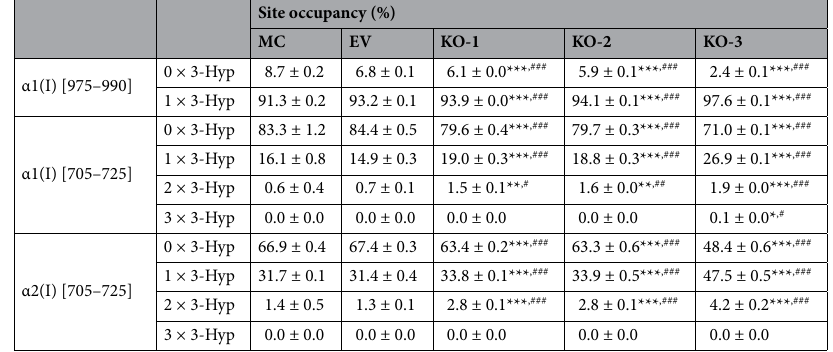
Table 6. Summary of site-specific modification analysis by mass spectrometry of prolyl 3-hydroxylation in type I collagen from controls (MC and EV) and KO clones. Prolyl 3-hydroxylation (%) represents the relative levels of prolyl 3-hydroxylation at α1 Pro-986 (0–1 × 3-Hyp), α1 Pro-707, 716, 719 (0–3 × 3-Hyp) and α2 Pro- 707, 716, 719 (0–3 × 3-Hyp) (total of 0–3 × 3-Hyp = 100%). Values represent mean ± S.D. (n = 3) of triplicate for each group. Statistical differences were determined by Kruskal–Wallis one-way analysis of variance and means comparison with the controls by Dunnett’s method. Hyp hydroxyproline, MC MC3T3-E1, EV empty vector, KO knock-out. * p < 0.05, ** p < 0.01, and *** p < 0.001 between MC and KO; # p < 0.05, ## p < 0.01, and ### p < 0.001 between EV and KO,